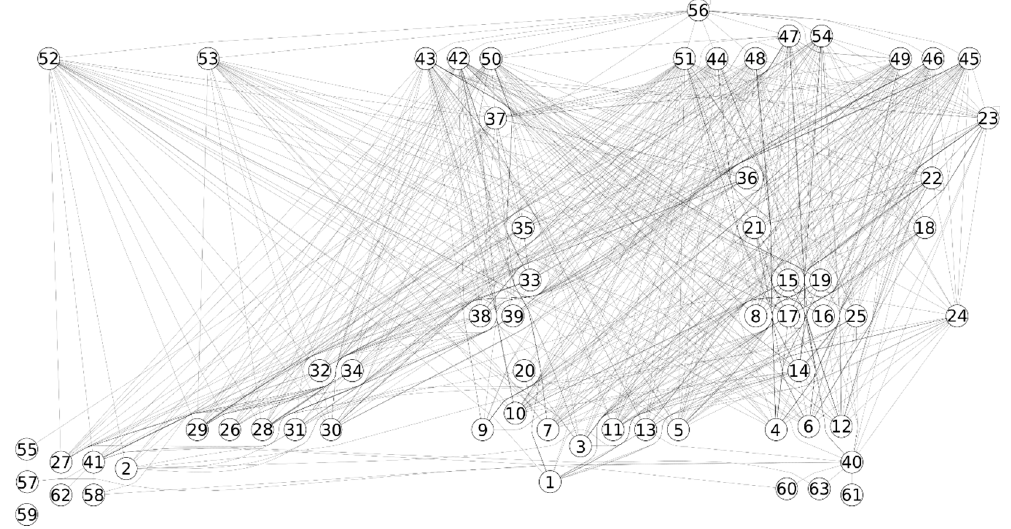
Figure 2. The food web of the Gulf of Naples at LTER-MC.